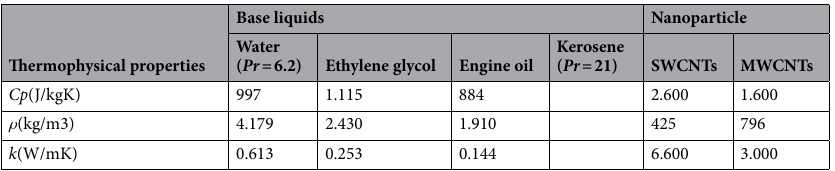
Table 2. Thermophysical properties of water and